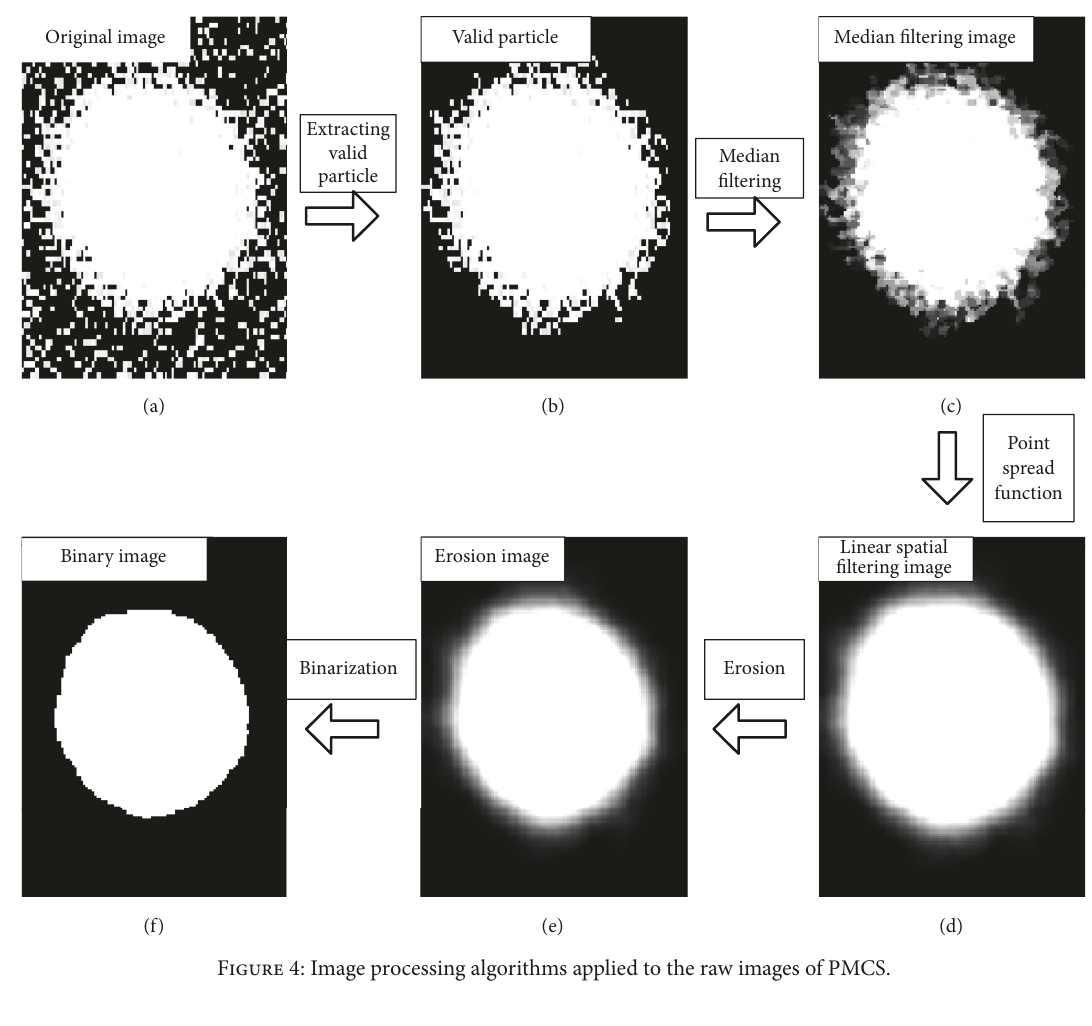
Figure 4: Image processing algorithms applied to the raw images of PMCS.